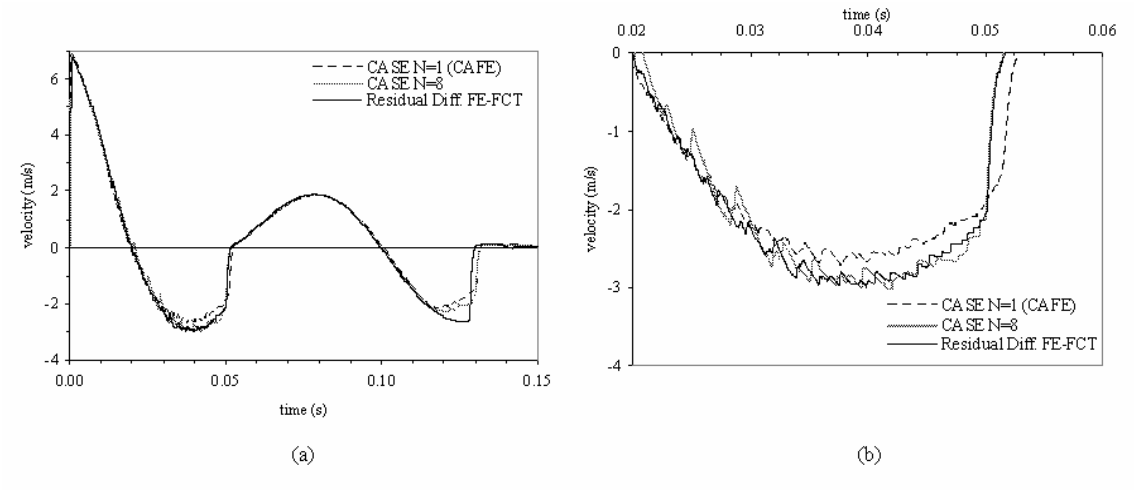
Fig. 7. Comparison of the m1 velocity response on two time scales using 41 DOF with β = 0.25 for CAFE/CASE and η D = 0.125 and η A = 0.10 for residual diffusion